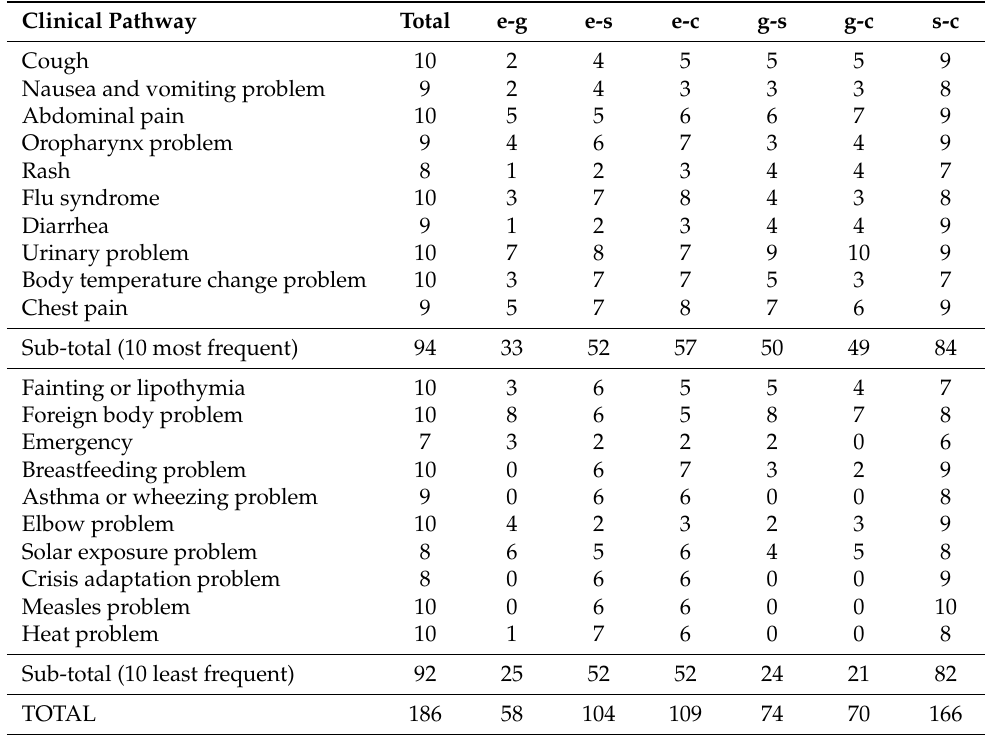
Table 6. Agreement between experienced analyst (e), ground truth (g) and SVM (s) and CNN (c) models. Clinical